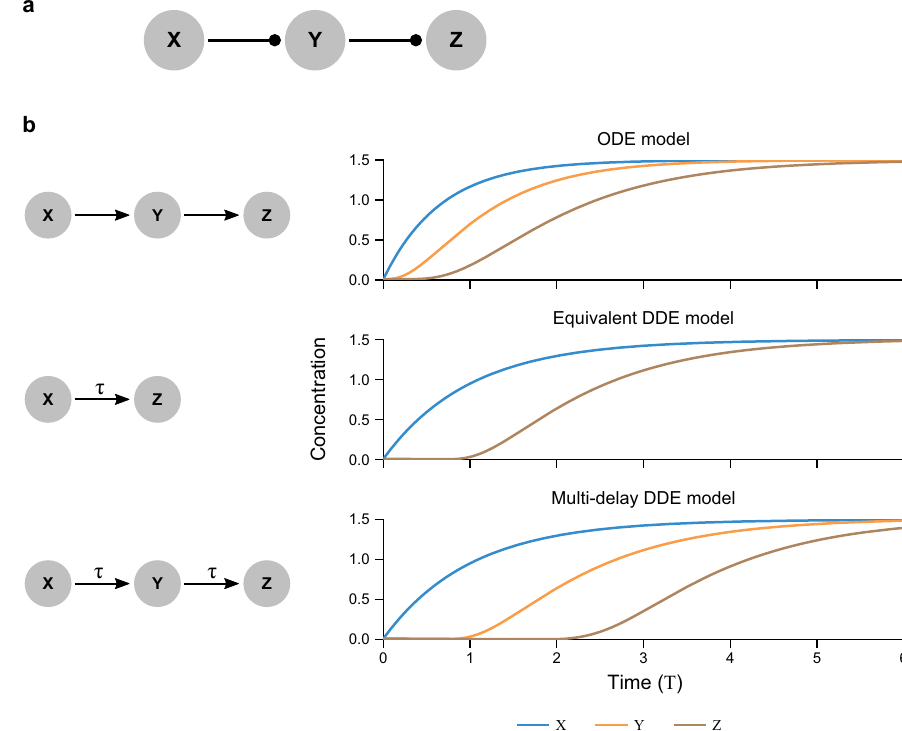
Fig. 3 A delayed model of cascades recapitulates the implicit delays in ODE models. a A cascade is a linear sequence of regulation steps, here X regulating Y regulating Z . b Standard models of cascades use ODEs (top), in which each step leads to a characteristic delay in the products Y and Z , which increases with each step based on the half-maximal inputs and degradation rates for each step. In an equivalent DDE model (middle), similar behavior is accomplished by replacing the explicit cascade of implicit delays with a single-step regulation including an explicit delay. A cascade in which each step contains an explicit delay (bottom) behaves analogously to delayed direct regulation (as in middle), with the fi nal step delayed by the sum of delays in each step. η X = 1.5, η Y = η Z = 2.17, β X = β Y = 1, β Z = 0.667, n X = n Y = − 2. For the bottom graph in ( b ), each step is governed by Eq. (9) with identical